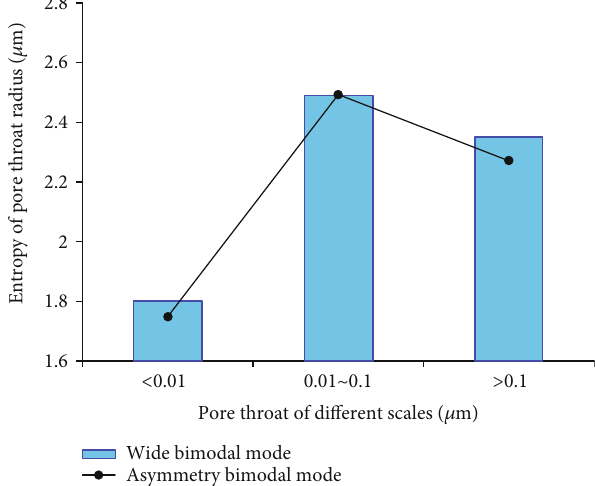
Figure 3: Entropy of microscale pore throat radius of di ff erent types of modal pore throat structure